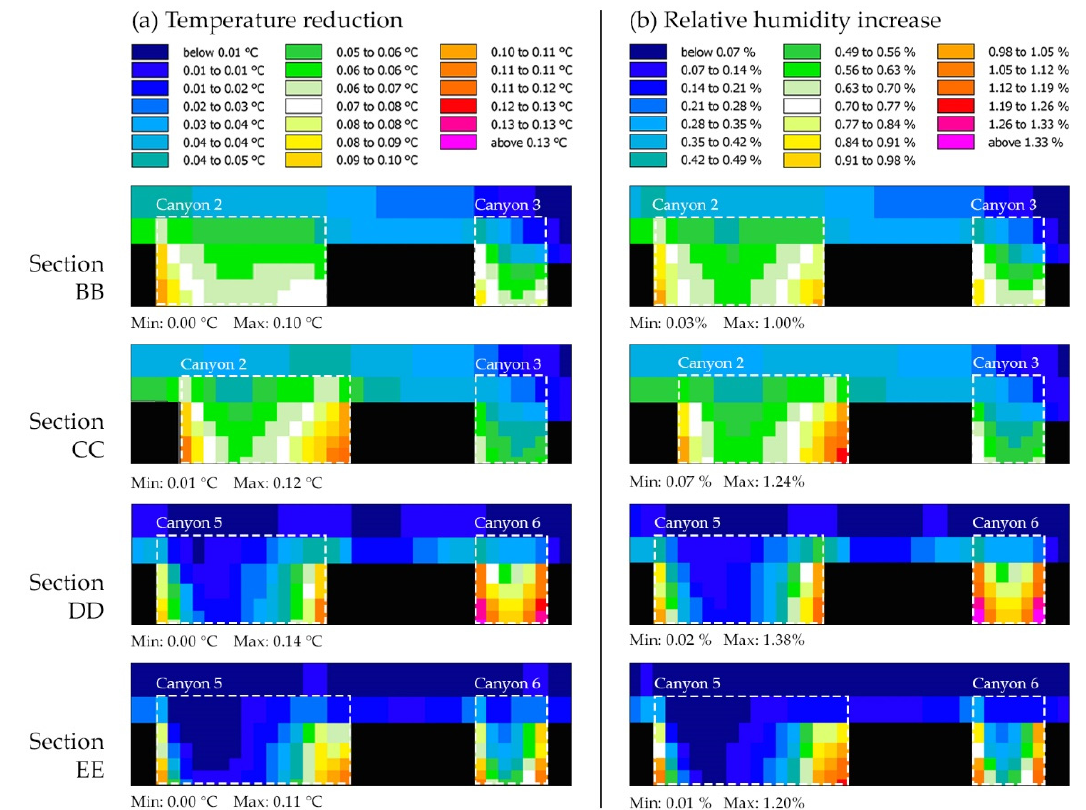
Figure 15. Differences for each urban canyon (Figure 2) considered inside the industrial district, in terms of the external air temperature (°C) ( a ) and the relative humidity (%) ( b ), comparing the base case and GW.2.